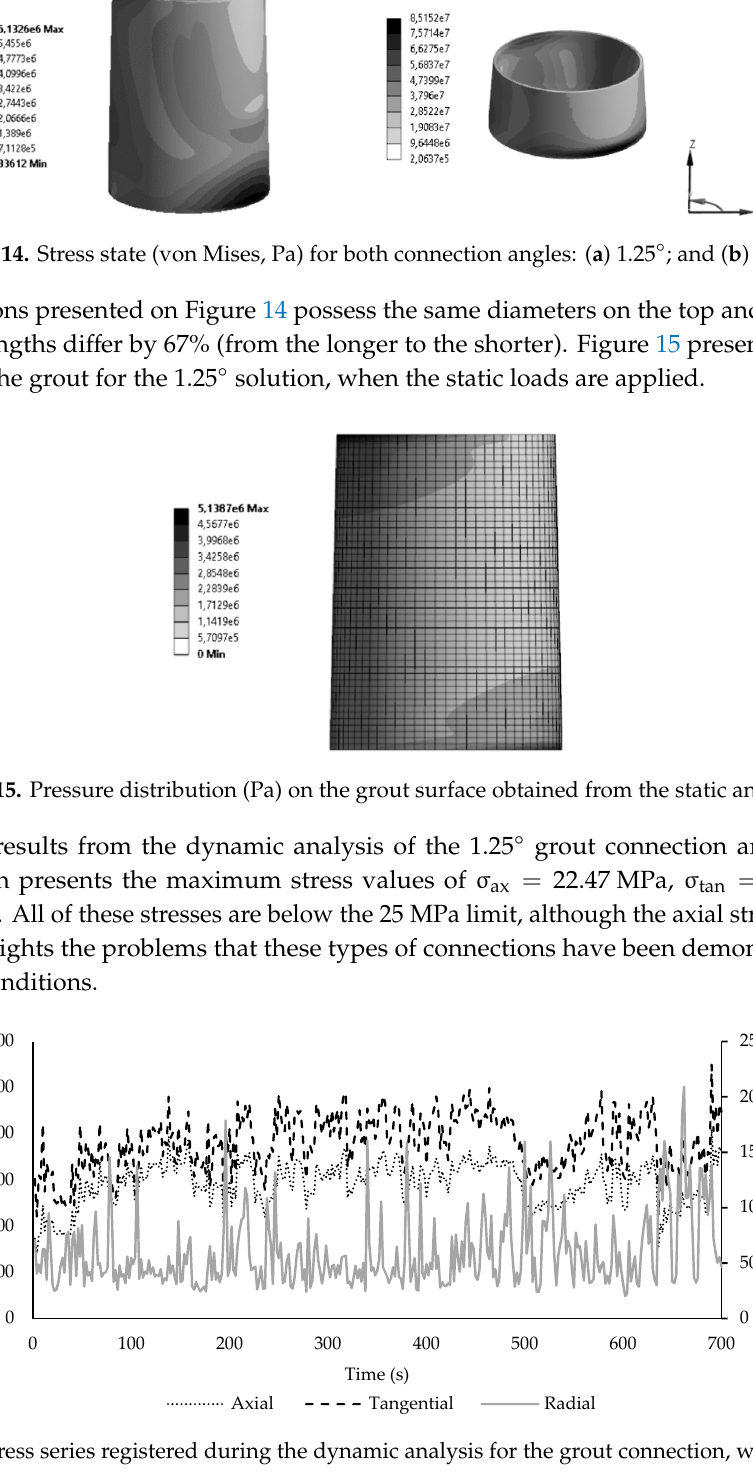
Figure 16. Stress series registered during the dynamic analysis for the grout connection, with the axial stress (point line), tangential stress (dashed line), and radial stress (solid line).